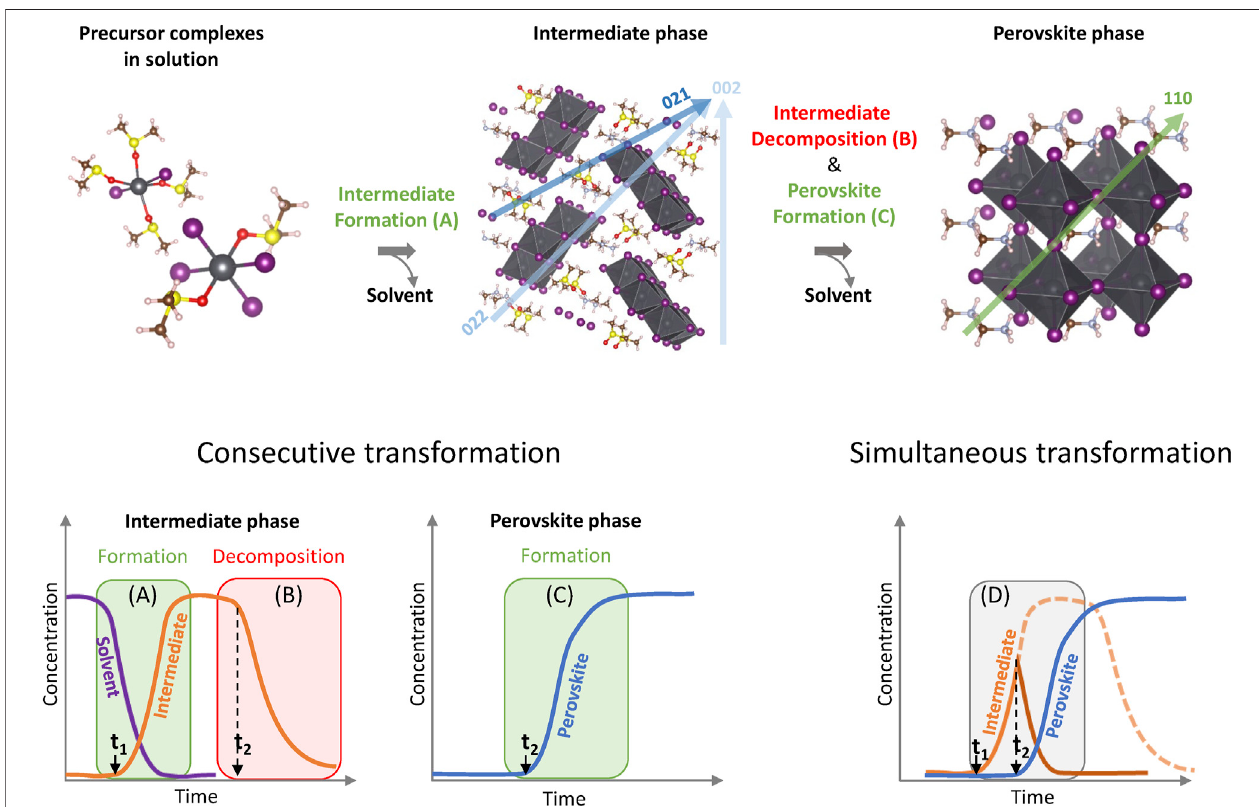
SCHEME 2 | Schematic representation of processes occurring during crystallization of MAPbI 3 from solution complexes to perovskite semiconductor (top) and kinetic curves for these processes (bottom).